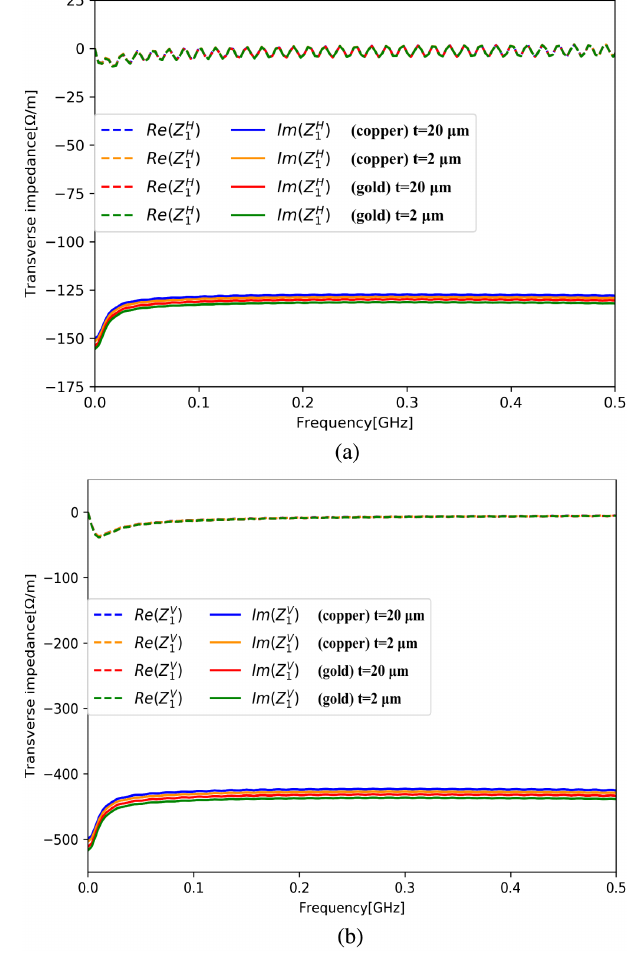
FIG. 11. Real and imaginary part of transverse broadband impedance for the ceramic rings shield by a conductive coating. (a) Horizontal (b)